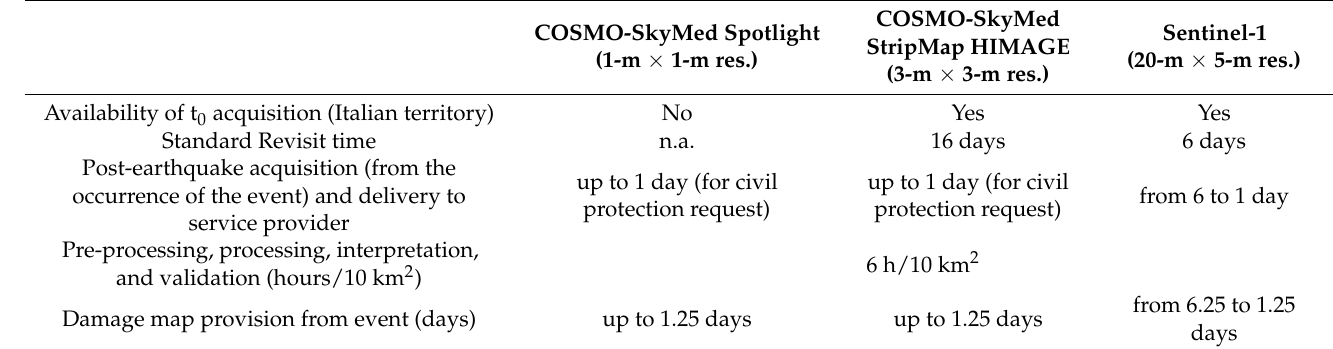
Table 5. Estimated times required for damage map provisioning for each dataset used to study post-earthquake emergencies. COSMO-SkyMed Sentinel-1 COSMO-SkyMed Spotlight StripMap HIMAGE (20-m × 5-m (1-m × 1-m res.) (3-m × 3-m res.)